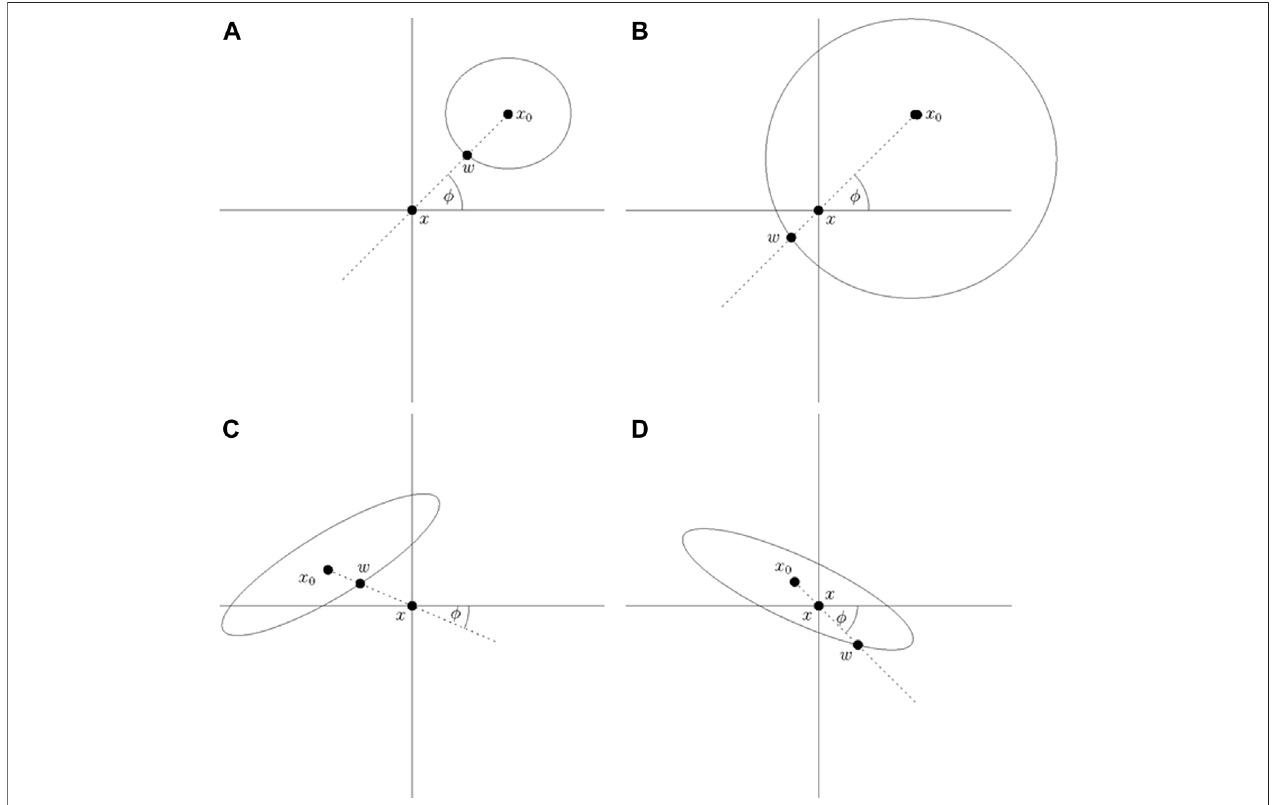
FIGURE1| Inthis fi gure, x 0 denotesasource, x denotesthereferencepoint,and w denotesthewavefront. (A) . r (0) > 0and r ( t ) (cid:1) d ( x , w ) > 0. (B) . r (0) > 0and r ( t ) (cid:1) d ( x , w ) < 0. (C) . r (0) < 0 and r ( t ) (cid:1) d ( x , w ) < 0. (D) . r (0) < 0 and r ( t ) (cid:1) d ( x , w ) > 0.